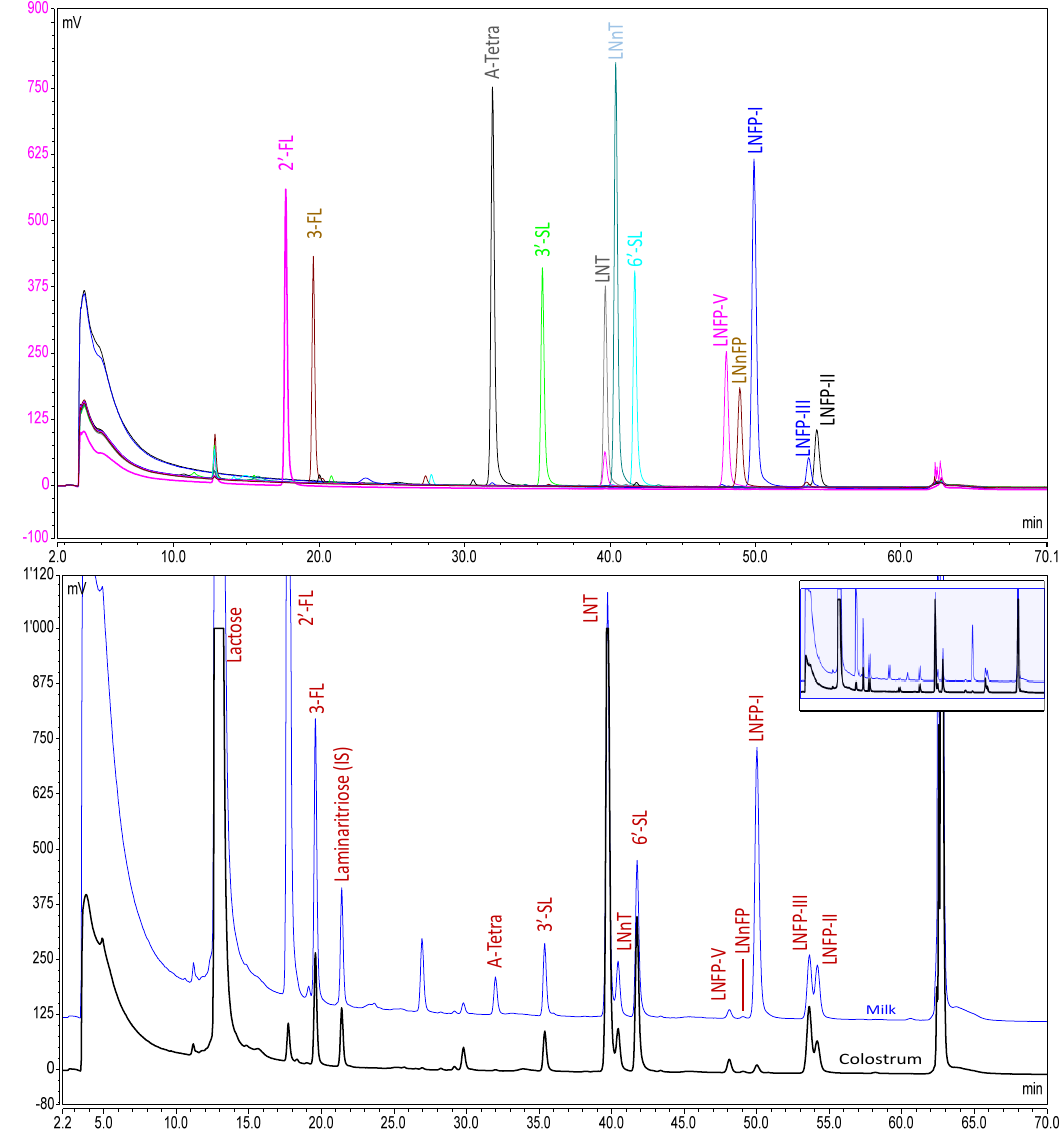
Figure 1. Chromatograms of human milk oligosaccharides (HMO). Top panel: overlay of the chromatograms of HMO standards injected individually. Lower panel: overlay of the chromatograms of pooled milk and pooled colostrum (both purchased from Lee Biosolutions, Maryland Heights, MO, USA).